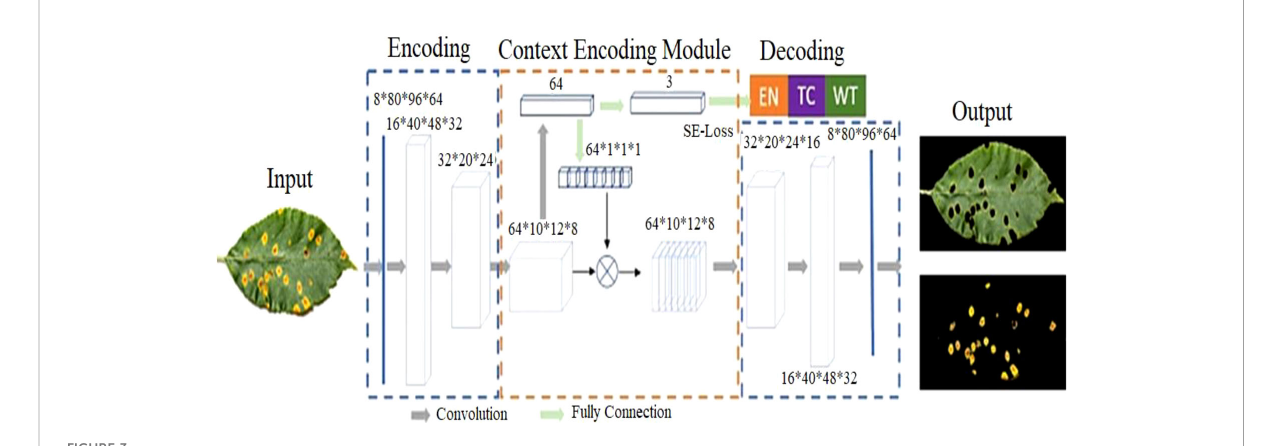
FIGURE 3 Proposed Leaf Lesion Segmentation model utilizing the CANet architecture.